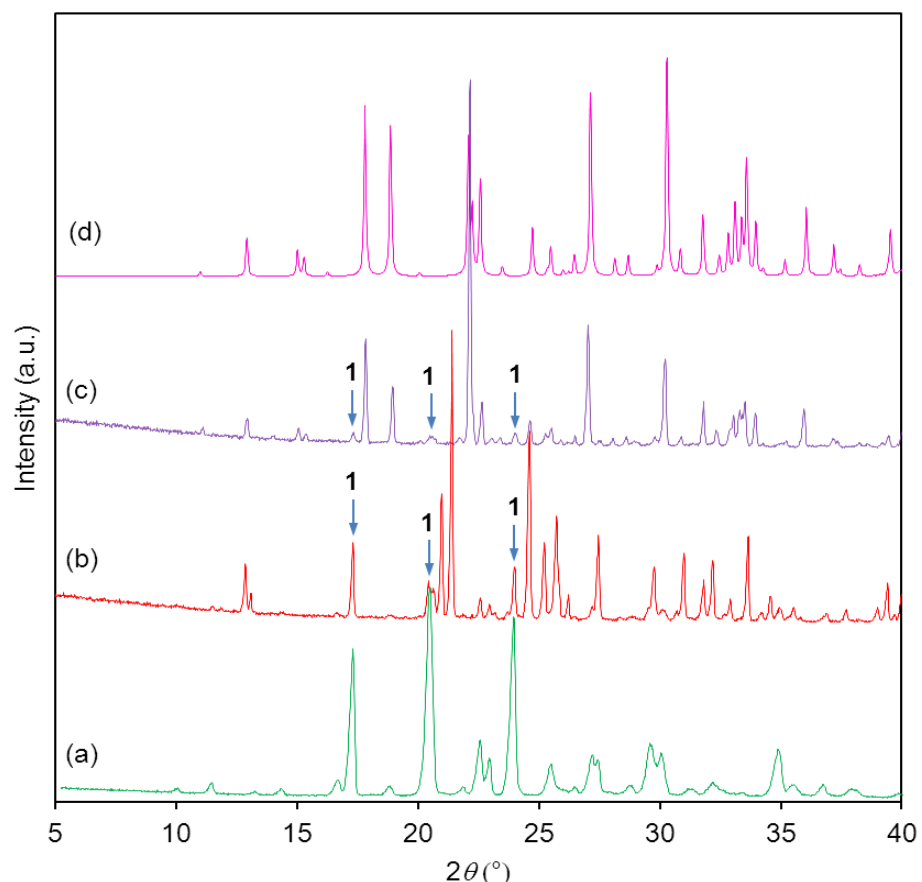
Figure 5. ( a ) Experimental PXRD of starting material 1 ; ( b ) Experimental PXRD of mono-potassium salt 3a ; ( c ) Experimental PXRD of dipotassium salt 3b ; ( d ) Calculated PXRD of dipotassium salt 3b . Impurities are indicated by arrows.